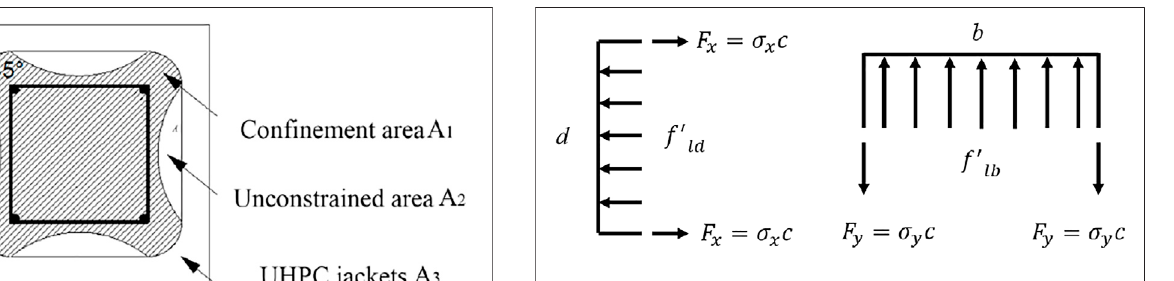
FIGURE 13 | Lateral force diagram of rectangular UHPC retro fi tting